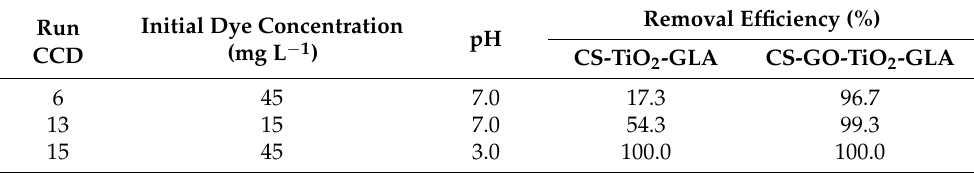
Table 6. Comparison of the removal efficiency of dye between the two adsorbent systems prepared (Amount of TiO 2 for all beads was 300 mg and 3 wt.% GO relative to TiO 2 ).